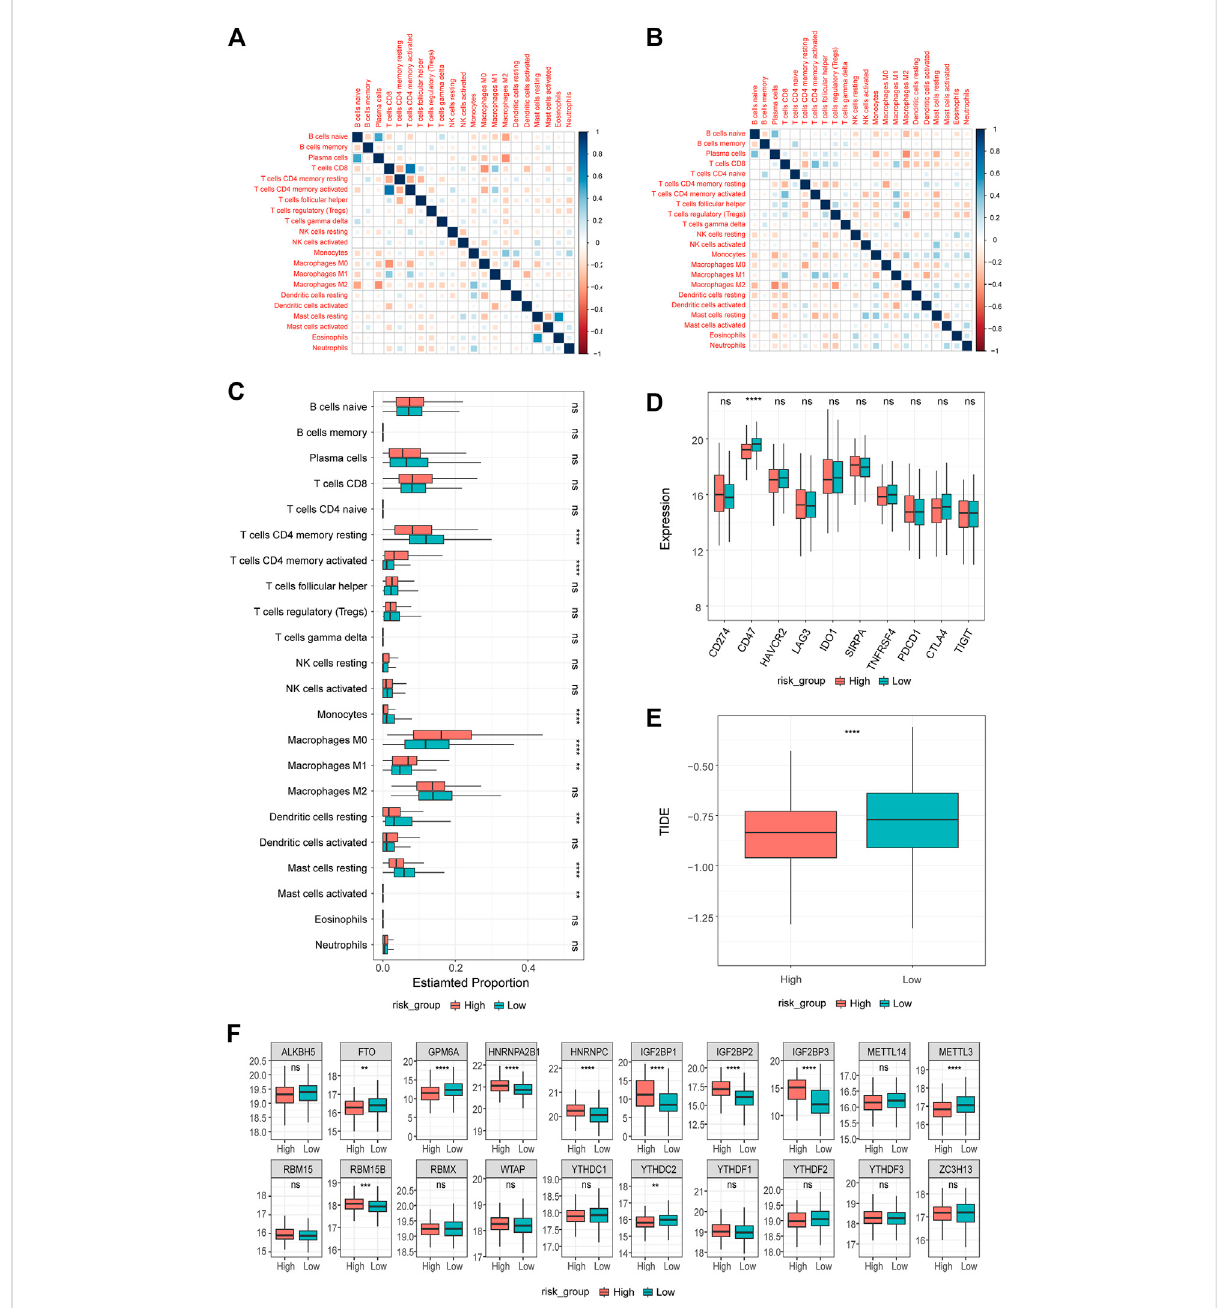
FIGURE 7 Results of immune in fi ltration analysis. (A,B) Correlation of immune in fi ltration in high-risk and low-risk groups. (C) Differences in immune in fi ltration between high and low risk groups. (D) Differences in immune checkpoints between high and low risk groups. Differences in (E) TIDE between high and low risk groups. Differences of (F) m6A regulon in high and low risk